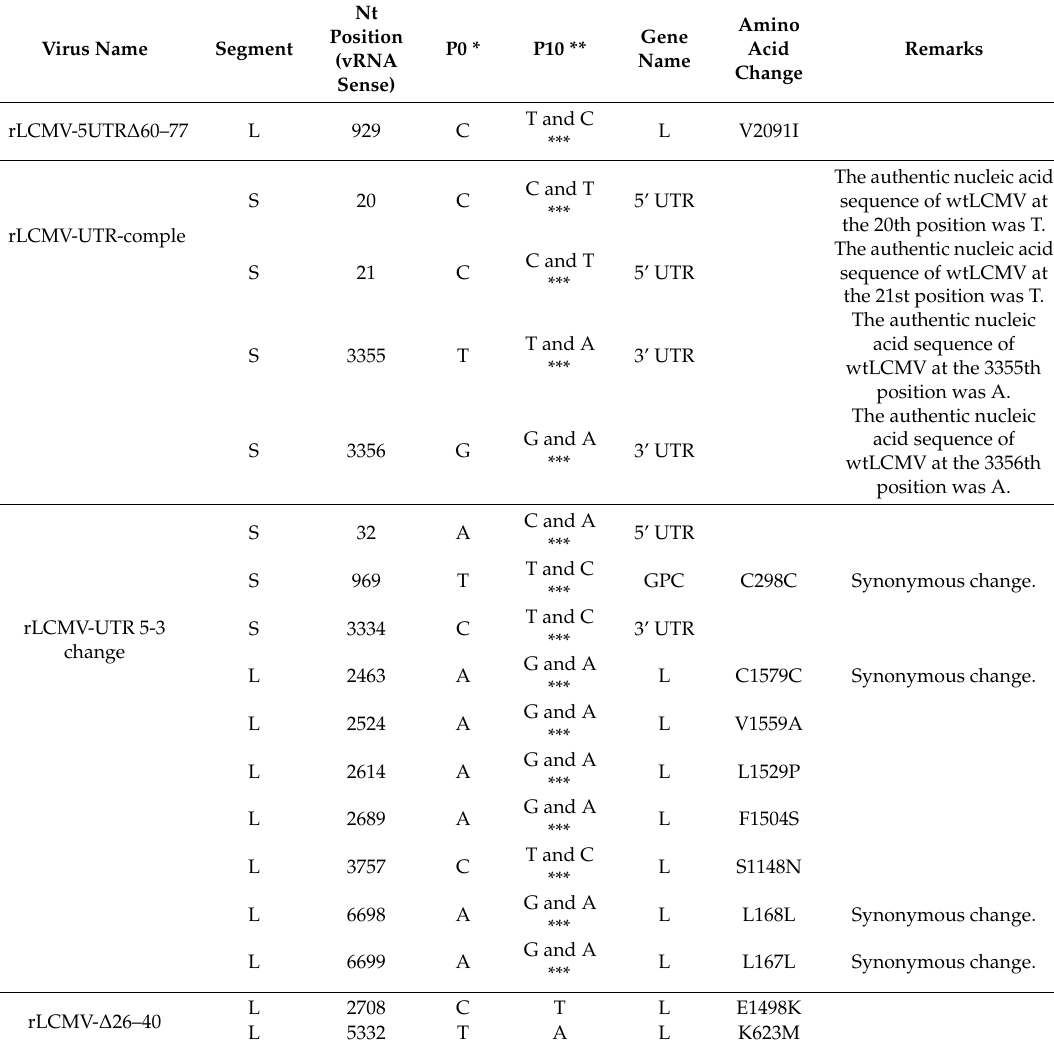
Table 5. Mutations acquired through the serial passage in Vero